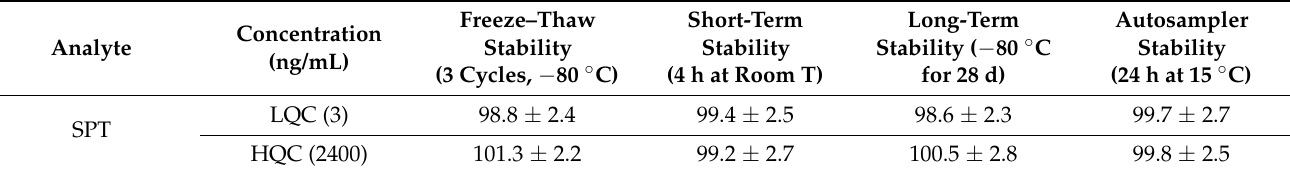
Table 4. Stability data of